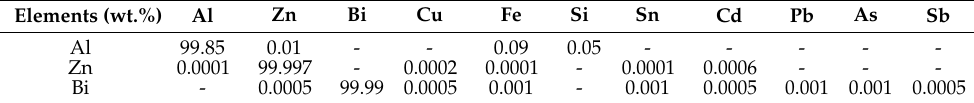
Table 1. Chemical compositions (wt.%) of metals used to prepare the Al-Bi(-X) alloys. Elements (wt.%)